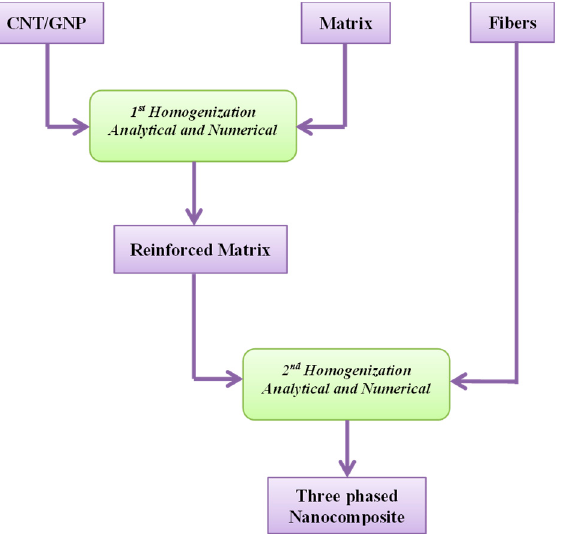
Figure 1. Multi-stage approach for mechanical homogenization of three-phased nanocomposite.